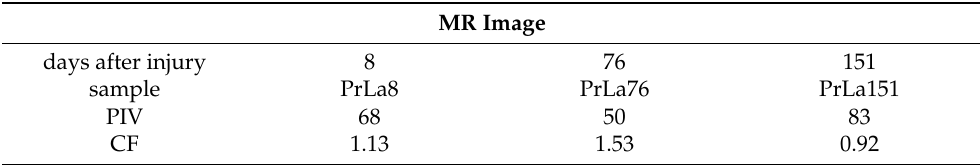
Table A2. Average pixel intensity value (PIV) signal of MR image and corresponding correction factors (CF) calculated from Equation (1). Average moisture content was